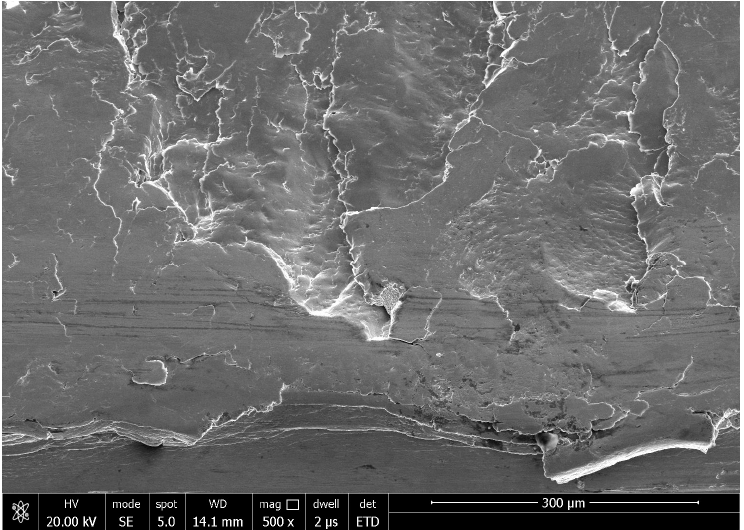
Figure 5. Metal extrusion and accumulation of the inner ring raceway. According to the damage degree, the six steel balls can be roughly divided into two categories, namely heavily damaged balls, including four steel balls; and lightly damaged balls, including two steel balls. The heavily damaged steel balls mainly show contact fatigue spalling with characteristics of obvious fan-shaped morphologies, lamellar damage and cracks, as shown in the typical macroscopic and microscopic appearance in Figure 6a,b, respectively. The lightly damaged steel balls show light wear, as shown in the typical macroscopic and microscopic appearance in Figure 7a,b, respectively.